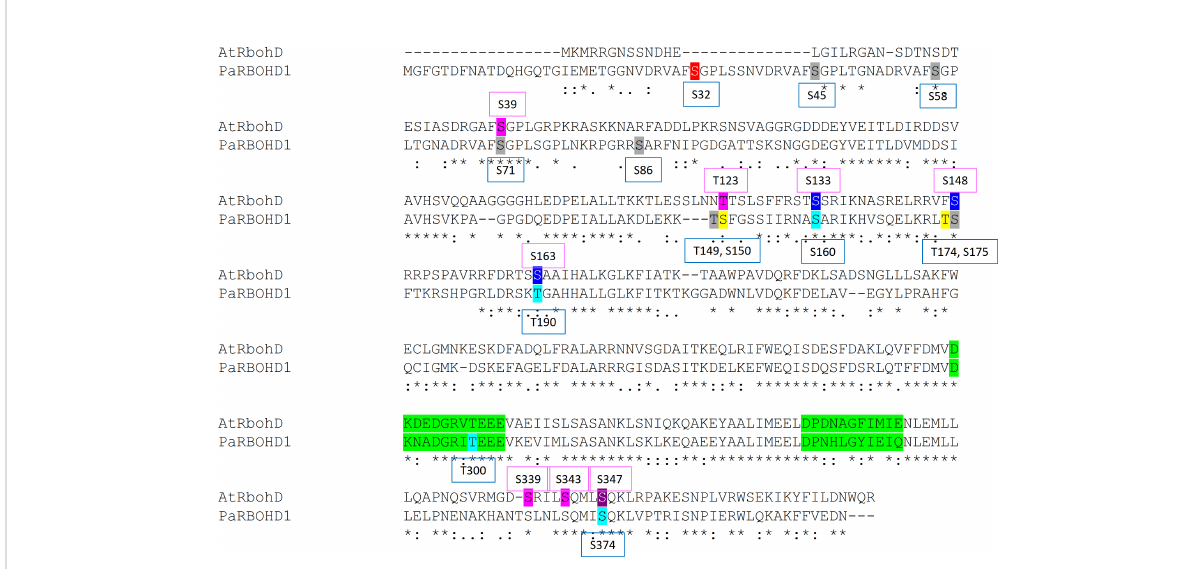
FIGURE 5 Phosphotarget sites in the N-terminus important for the PaRBOH1 activity, and comparison for those reported in AtRBOHD. The putative EF hands have been marked with a green colour. Colour codes in the AtRBOHD sequence: pink, a target site phosphorylated by BIK1; blue, a target site phosphorylated by CDKs; purple, a target site for both BIK1 and CDKs. Colour codes in the PaRBOH1 sequence: light blue, a phosphotarget site showing positive response in HEK cells; grey, a site showing no response in HEK cells; yellow, an amino acid having phosphorylation in the phosphoproteomic analysis and giving a positive response in HEK cell assays; red, an amino acid having phosphorylation in the phosphoproteomic analysis, but not giving a positive response in HEK cells. For references, see